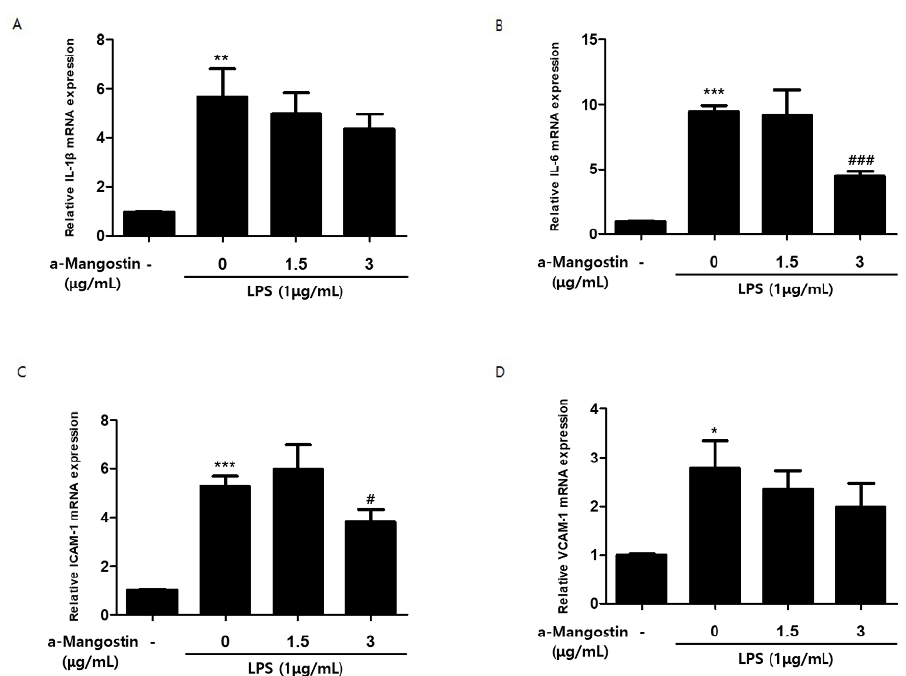
Figure 2. The effect of α -MG on the mRNA expression of LPS-induced inflammatory mediators analyzed by qPCR. Relative mRNA expression levels of ( A ) IL- 1β, ( B ) IL-6, ( C ) ICAM-1, and ( D ) VCAM- 1 were normalized by β -actin (* p < 0.05, ** p < 0.01 and *** p < 0.001 compared to the control group, # p < 0.05 and ### p < 0.001 compared to the LPS-only treated group).